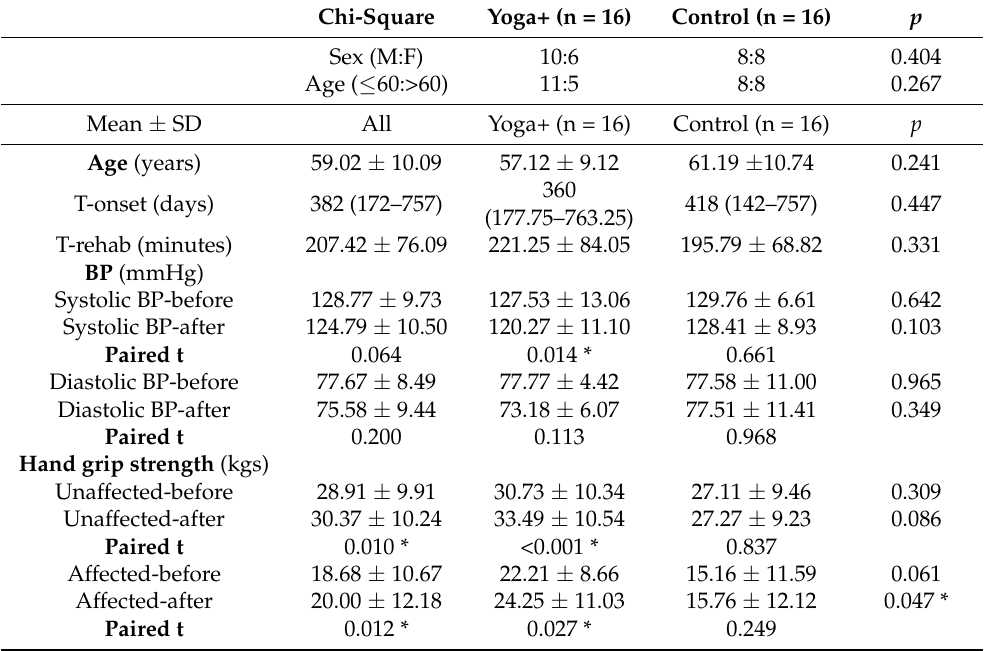
Table 1. The chi-square test, blood pressure, and hand grip strength for the yoga and control